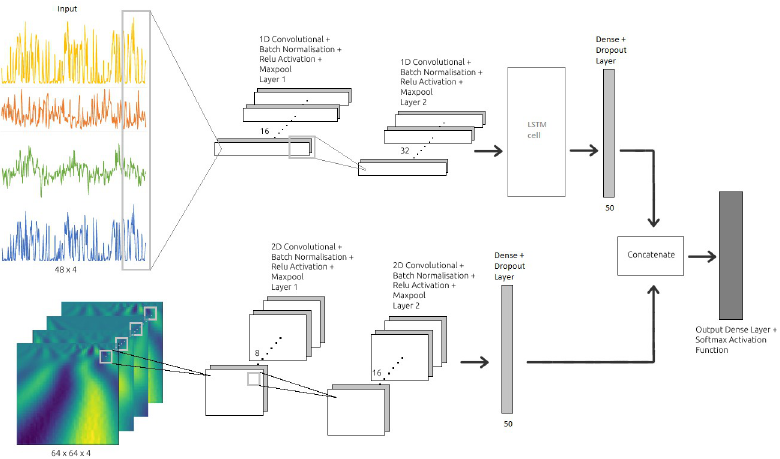
Fig 3. Architecture of the proposed deep neural network, with input shape and number of channels shown below the input, number of neurons below the dense layer. The features of time-dependent behavioural signals are captured via two convolutional-1D layers and a LSTM layer. CW transformed frequency domain signals are simultaneously processed by two convolutional-2D layers. The features extracted by both branches are then concatenated and sent through a final fully connected layer and a softmax function to return the probability of each class. The number of filters in each convolutional layer and units in LSTM and dense layers are tuned heuristically. The model is trained to minimize the sparse categorical crossentropy loss between the target class and the predicted class.